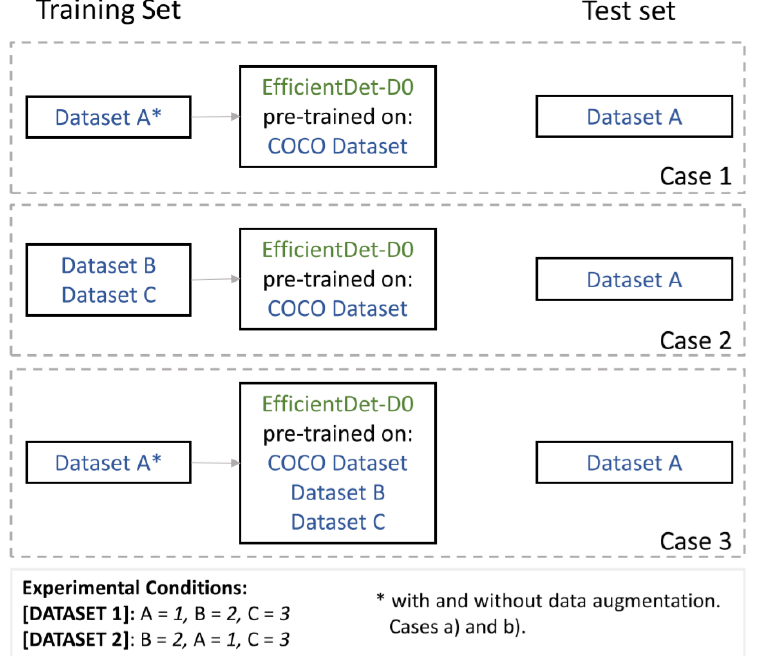
Figure 4. Scheme of the